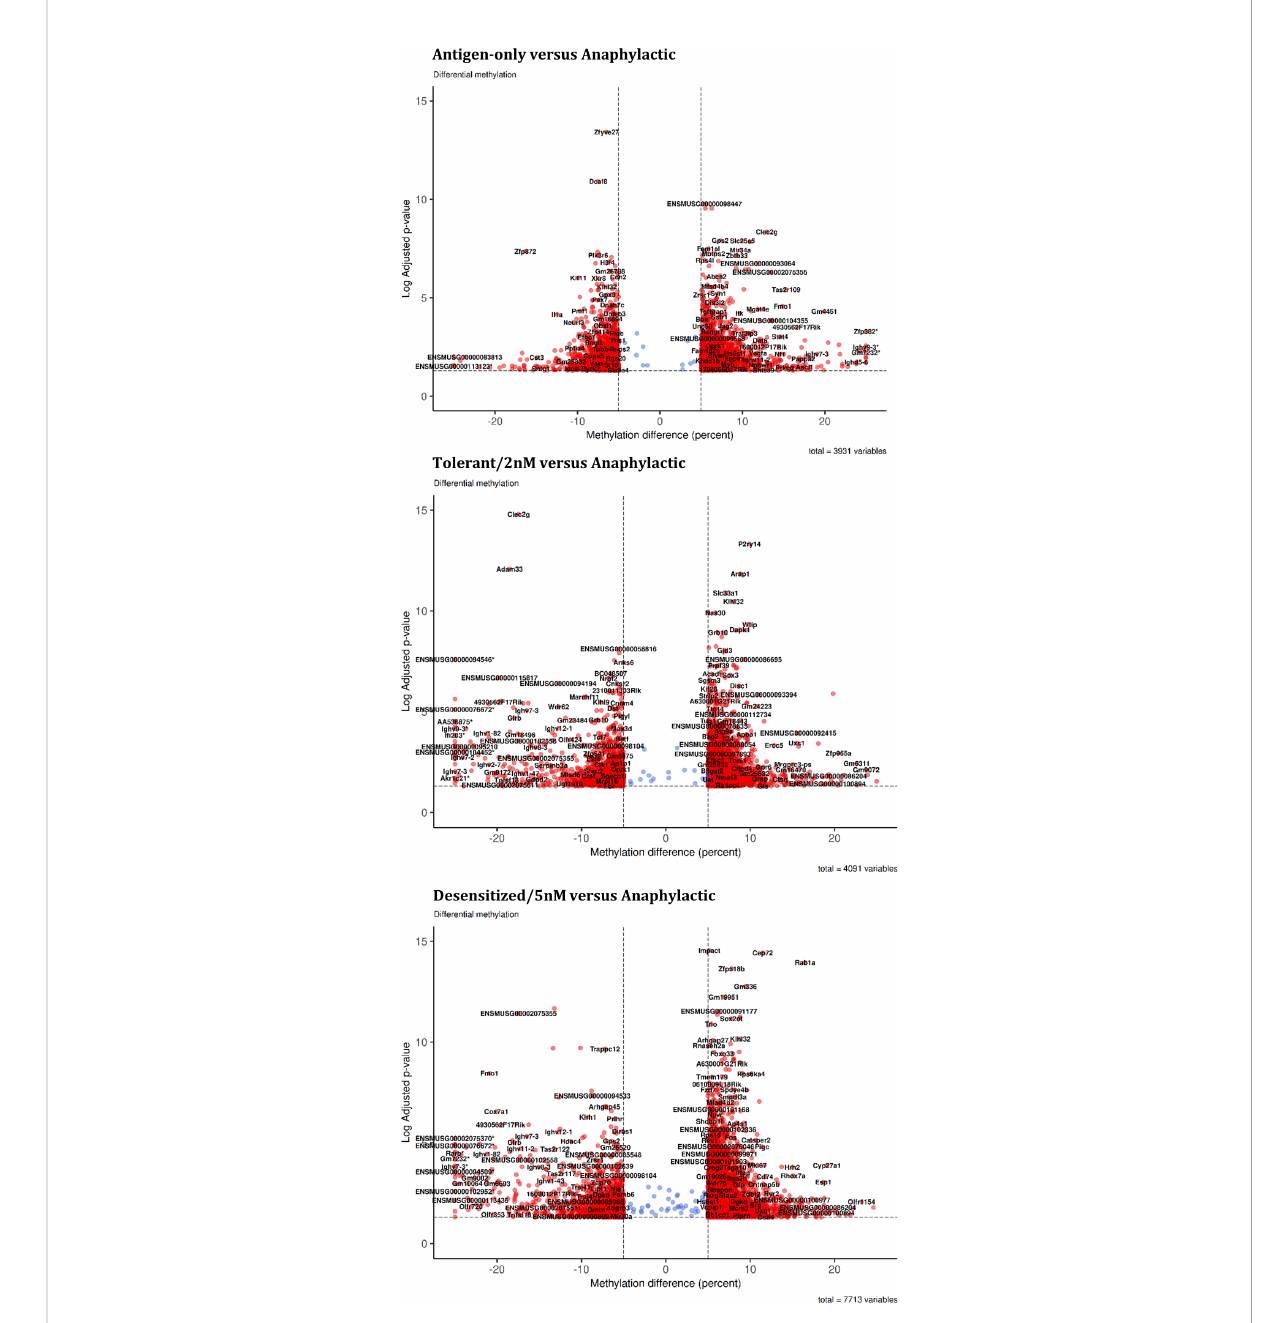
FIGURE 2 Global changes in promoters cytosines methylation. Volcano plot for each comparison in the summary table. *DMPR with abs (methylation difference) >